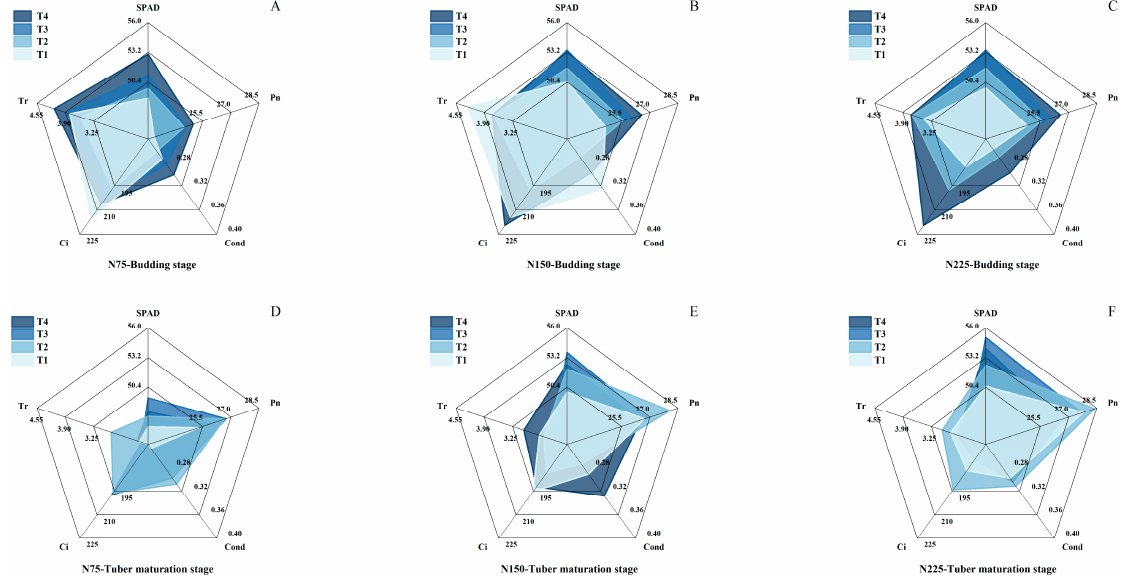
Figure 2. Comparison of photosynthetic characters of potato leaf at budding stage ( A – C ) and tuber maturation stage ( D – F ). Each angle of the pentagon showed di ff erent traits, SPAD, Pn-net photo- synthetic rate (µmol CO 2 m − 2 s − 1 ), Cond-stomatal conductance (mol H 2 O m − 2 s − 1 ), Ci-Intercellular CO 2 concentration (µmol CO 2 mol − 1 ), Tr,-transpiration rate (mmol H 2 O m − 2 s − 1 ). Base/topdressing ratio of T1, T2, T3, and T4 is 2:8, 5:5, 8:2 and 10:0, respectively.